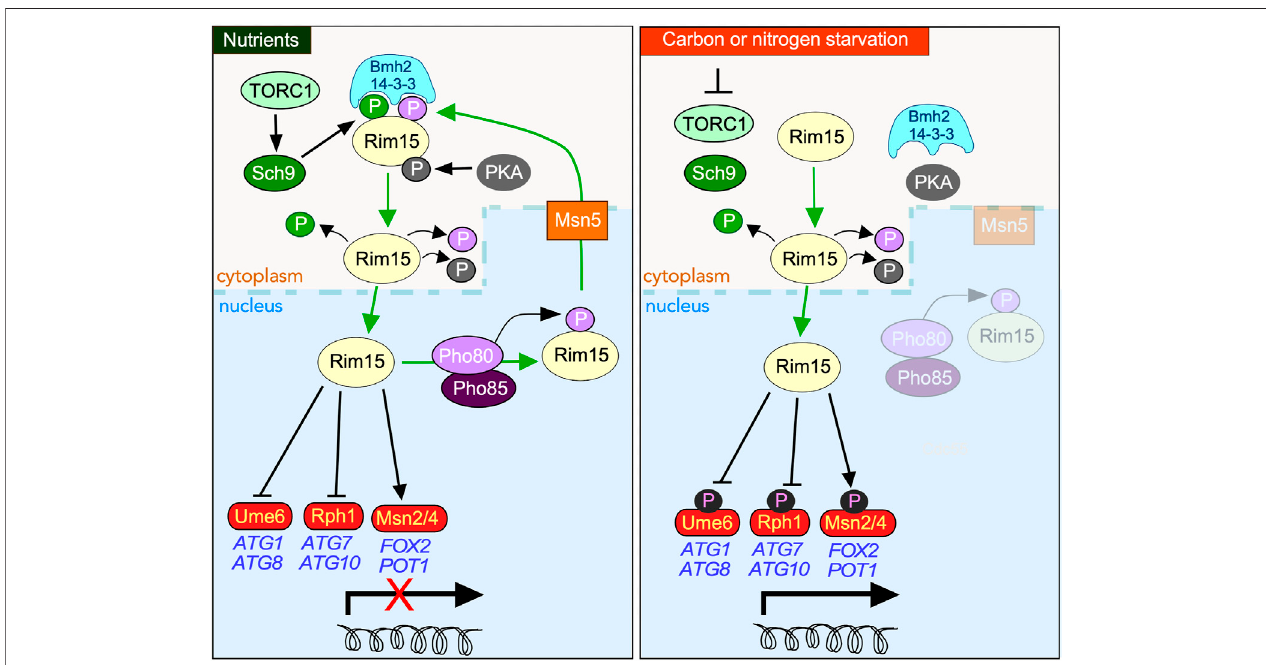
FIGURE 1 | Overview of the protein kinases controlling the subcellular address of Rim15 in response to nutrient availability. In nutrient replete media (left-hand panel),nuclearRim15isphosphorylated bythePho80/Pho85Cdkwhichmediates itnuclear exportbytheexportin Msn5. Cytoplasmic sequestrationofRim15requires additional phosphorylation by TORC1 activated Sch9, permitting its engagement by the 14-3-3 anchor protein Bmh2. PKA also directly phosphorylates Rim15, contributing to its cytoplasmic retention as well as inhibiting its kinase activity in response to glucose. Entrance into the nucleus is dependent upon removal of all three phosphorylation events. In response to carbon or nitrogen starvation (right-hand panel) Rim15 is retained in the nucleus where it phosphorylates both transcriptional repressors (Ume6, Rph1), and activators (Msn2/4 and Gis1 (not shown)), promoting the upregulation of stress response genes.